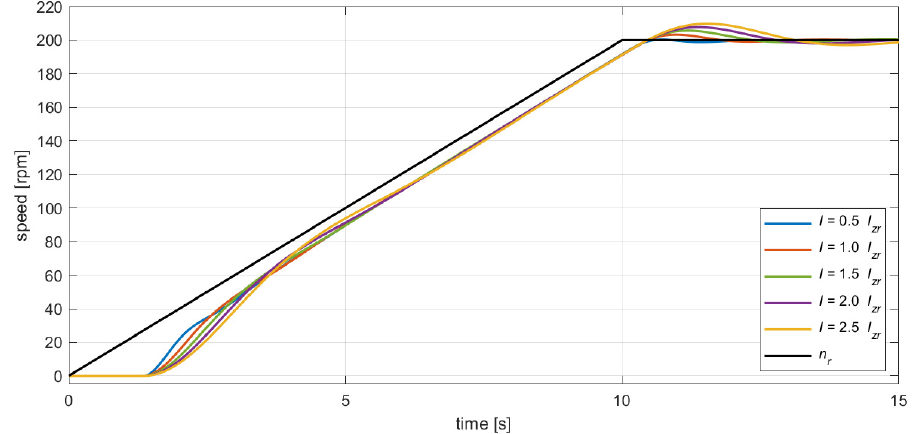
Figure 11. Result of simulation of the waveform of rotational speed, n s , for various moments of inertia of the system ( K P = 0.015, T I = 0.75 s ) .